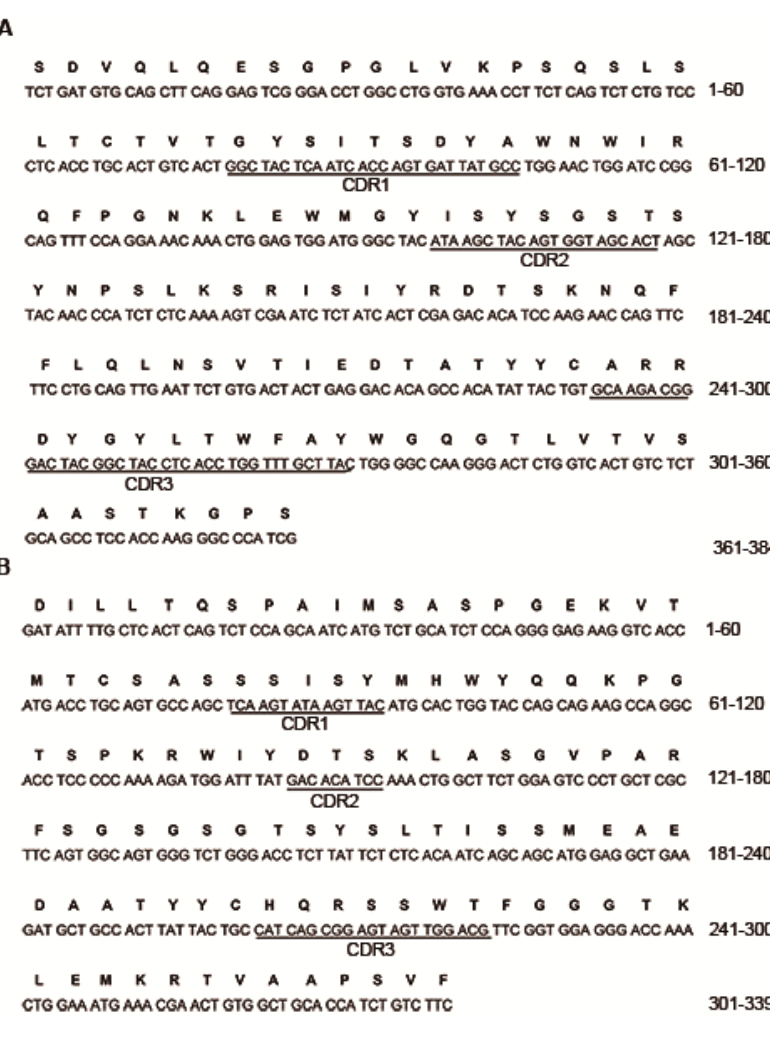
Figure 2. Nucleotide and deduced amino acid sequences of V complementary determining regions (CDRs) are underlined, based on the analysis of VBASE2 database. ( A ) Nucleotide sequence of VH and deduced amino acid sequence of ; ( B ) Nucleotide sequence of V V H